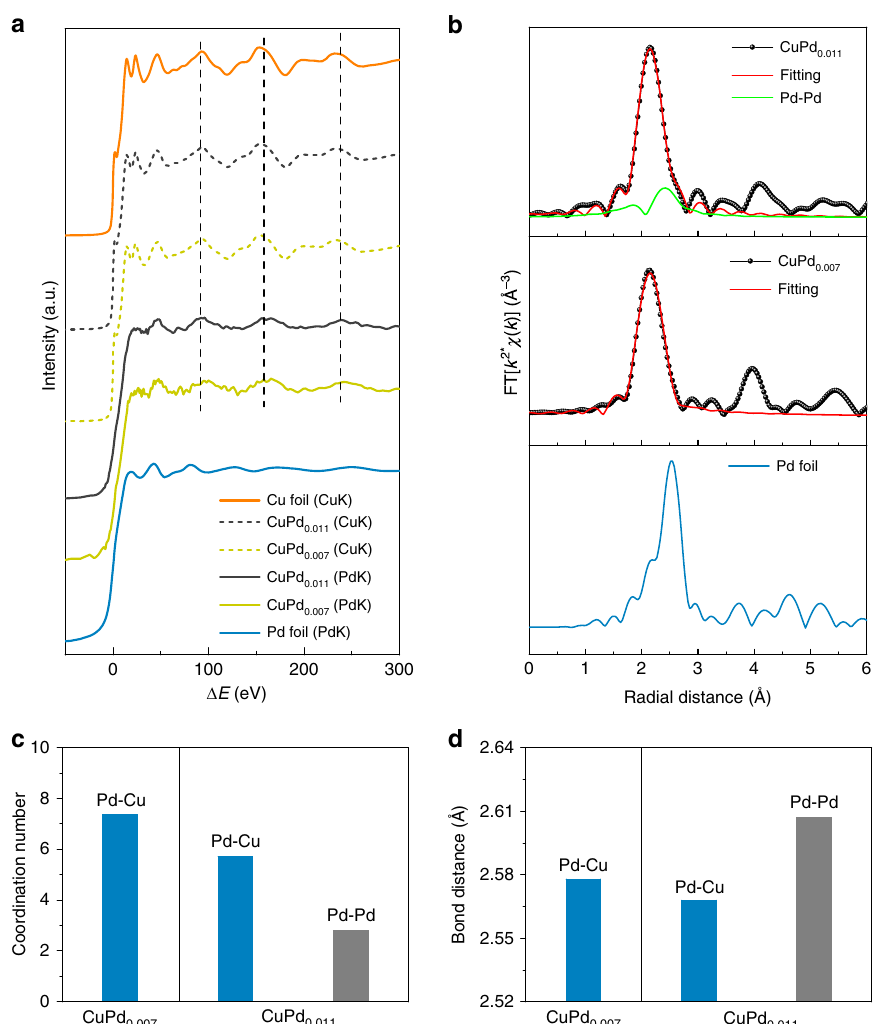
Fig. 3 X-ray absorption analysis of Pd-doped Cu electrocatalysts. a A plot of XAFS spectra at a relative energy scale for the Pd K-edge and Cu K-edge of Pd foil, CuPd 0.007 , CuPd 0.011 and Cu foil by subtracting the Pd K-edge and Cu K-edge photon energies (E) with the absorption thresholds (E 0 ) of Pd 1 s (24350 eV) and Cu 1 s (8979 eV), respectively, i.e. Δ E = E – E 0 . b Pd K-edge EXAFS spectra as well as corresponding fi tting spectra of Pd foil (bottom), CuPd 0.007 (middle) and CuPd 0.011 (top), recorded at a radial distance scale. c , d Simulated coordination number ( c ) and bond distance ( d ) of CuPd 0.007 (left) and CuPd 0.011 (right) extracted from their Pd K-edge EXAFS. Cu K-edge XAS was performed in operando mode during COR at − 0.62 V vs. RHE in 1 M KOH, whereas ex-situ Pd K-edge was conducted after COR at − 0.62 V vs. RHE in 1